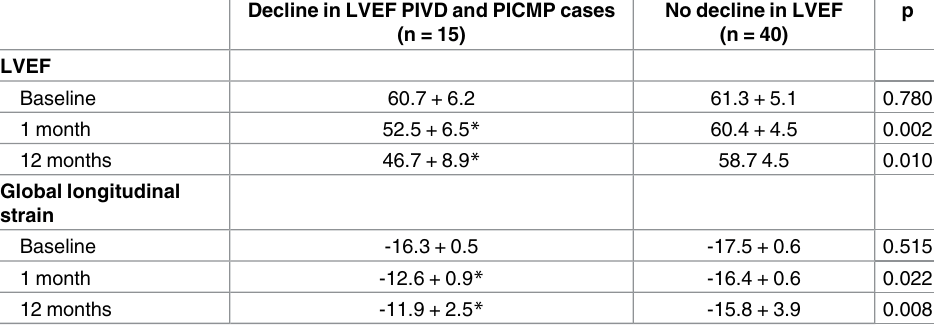
Table 2. Differencesin LVEF and GLS values between patients with and without pacing-induced LV